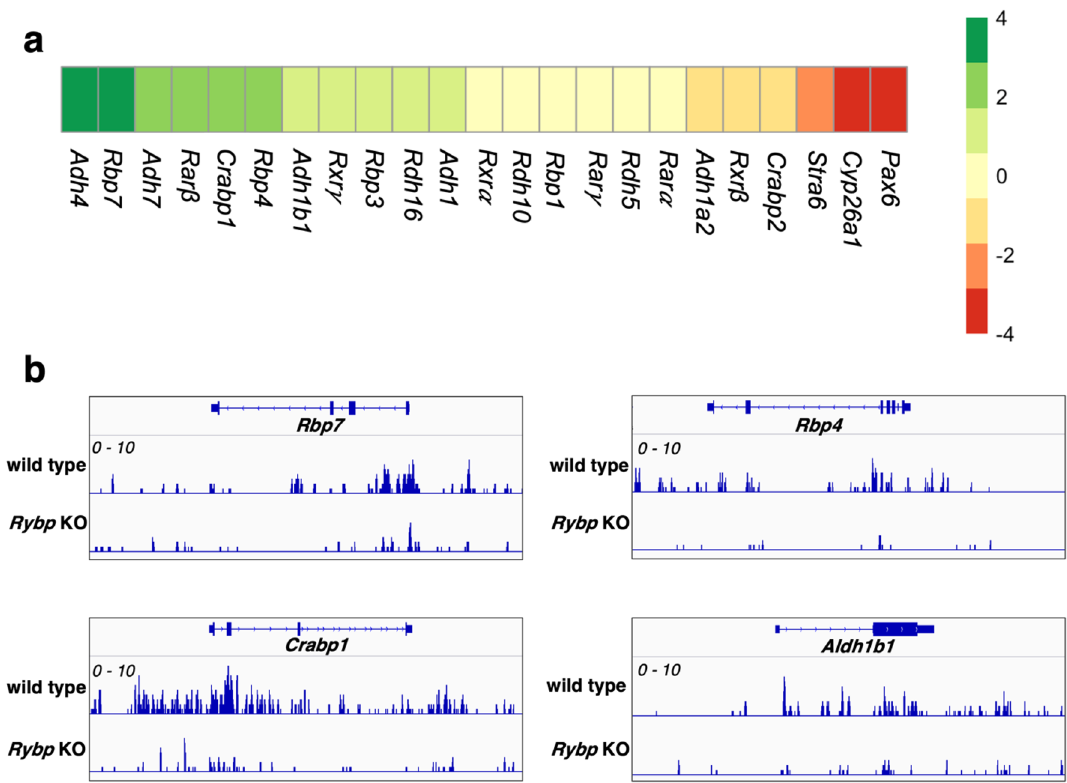
Figure 1. Gene expression changes of RA signaling pathway members in wild type and Rybp −/− ES cells. ( a ) Heatmap of RA signaling related gene expression changes comparing Rybp −/− ES cells to wild type cells revealed altered expression of several RA pathway member genes. Green and red indicate upregulation (log 2 fold change ≥ 1.5) and downregulation (log 2 fold change ≤ − 1.5) respectively and yellow indicates genes that did not display significant expression changes. Heatmaps were generated using pheatmap (R package version 1.0.12) in Rstudio 1.3.959 ( http:// www. rstud io. com/) ( b ) ChIP-seq analysis of H2AK119ub1 marks in wild type and Rybp −/− ES cells revealed loss of H2AK119ub1 at the genomic locus of RA pathway members. Data range